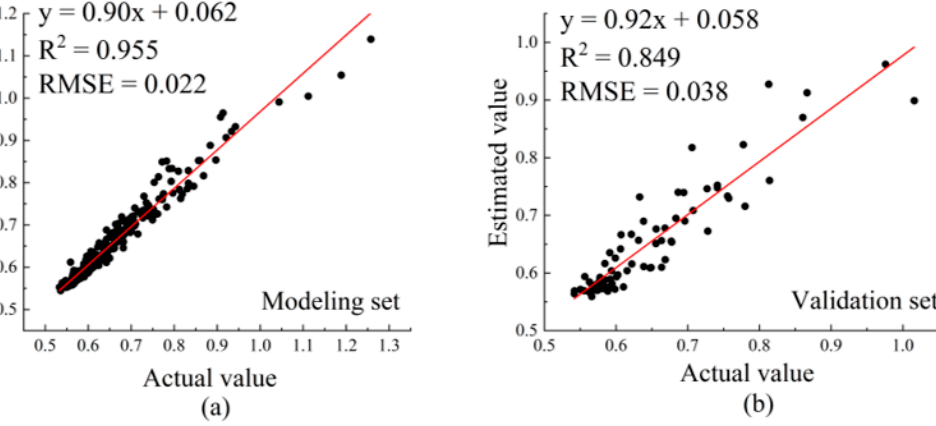
Figure 8. Fi tt ing analysis of estimation results of SSA-RF model: ( a ) modeling set; ( b ) validation set.